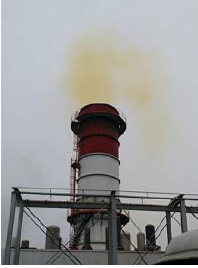
Figure 1. The yellow plume during the start-up period.